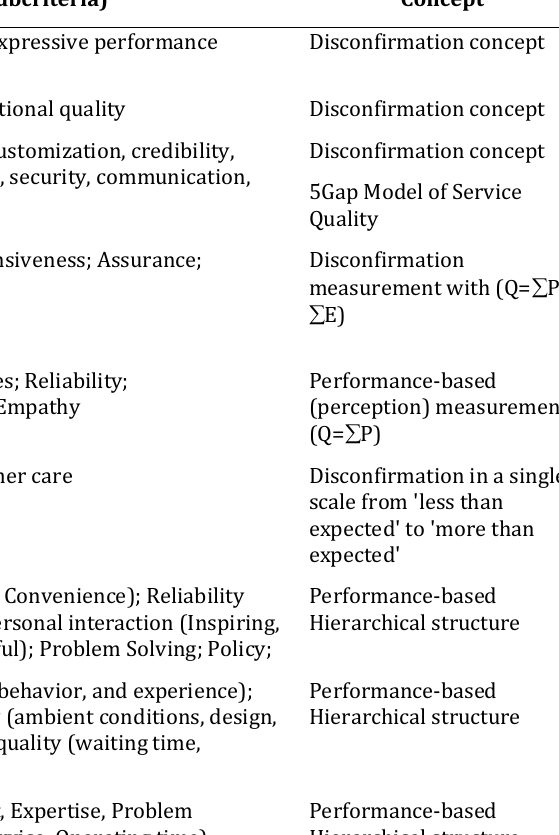
Table 2: Service quality models Criteria and concepts